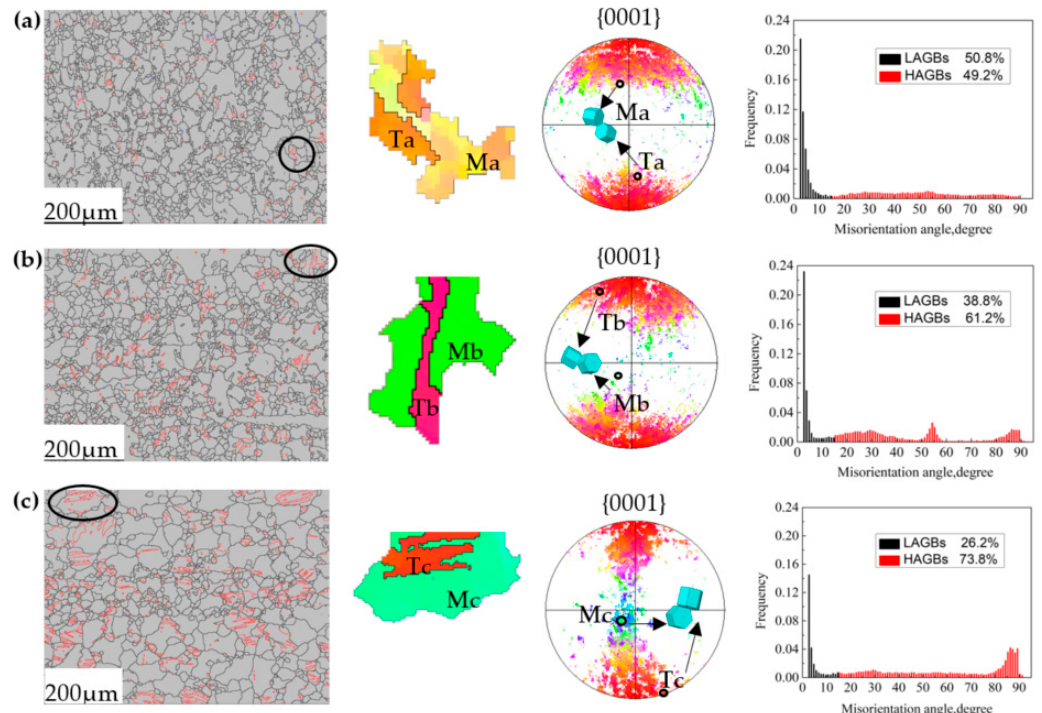
Figure 7. Boundary structure maps , electron backscattering diffraction (EBSD) maps of typical grain, {0001} pole figure, and grain boundary misorientation map under uniaxial compression to 8% of ( a ) E0; ( b ) E45; ( c ) E90. (LAGBs: low angle grain boundaries between 0°and 15°; HAGBs: high angle grain boundaries higher than 15°).